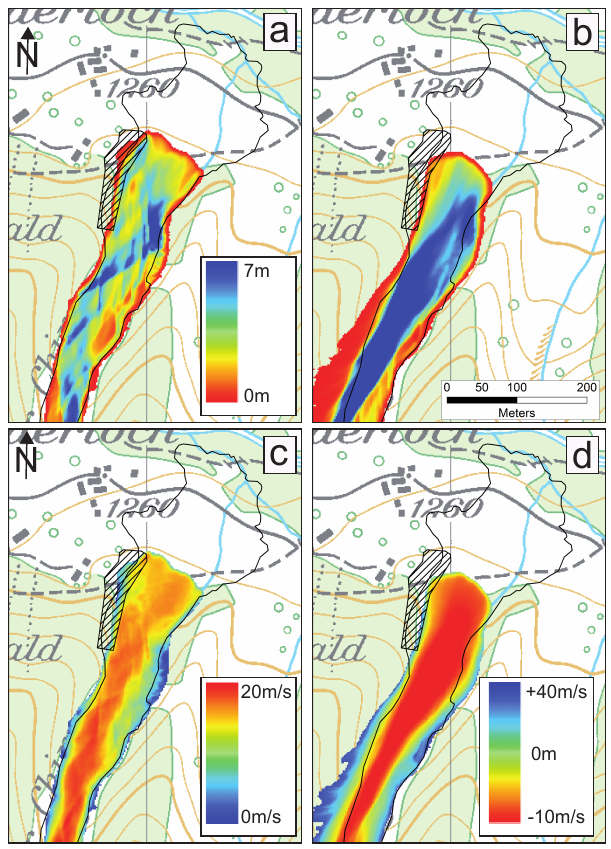
Fig. 18. Comparison between simulations ] 1 and ] 3. Panels show the arrival of the avalanche at the dam. Panels (a) and (b) show screen shots of the simulated flow depth for wet- and dry-snow avalanches, respectively, while panels (c) and (d) show the corre- sponding velocity